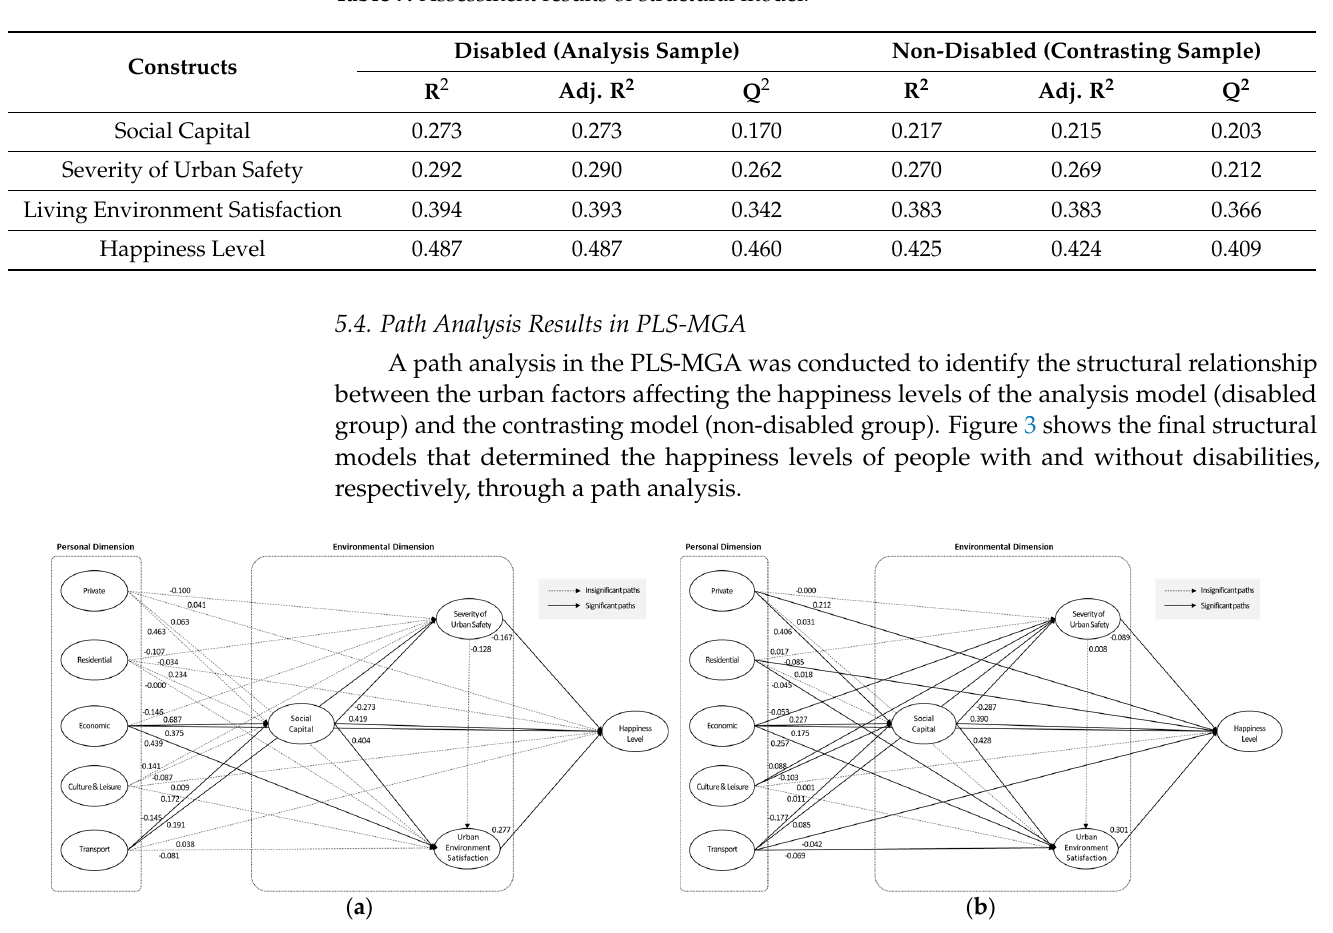
Table 7. Assessment results of structural model.